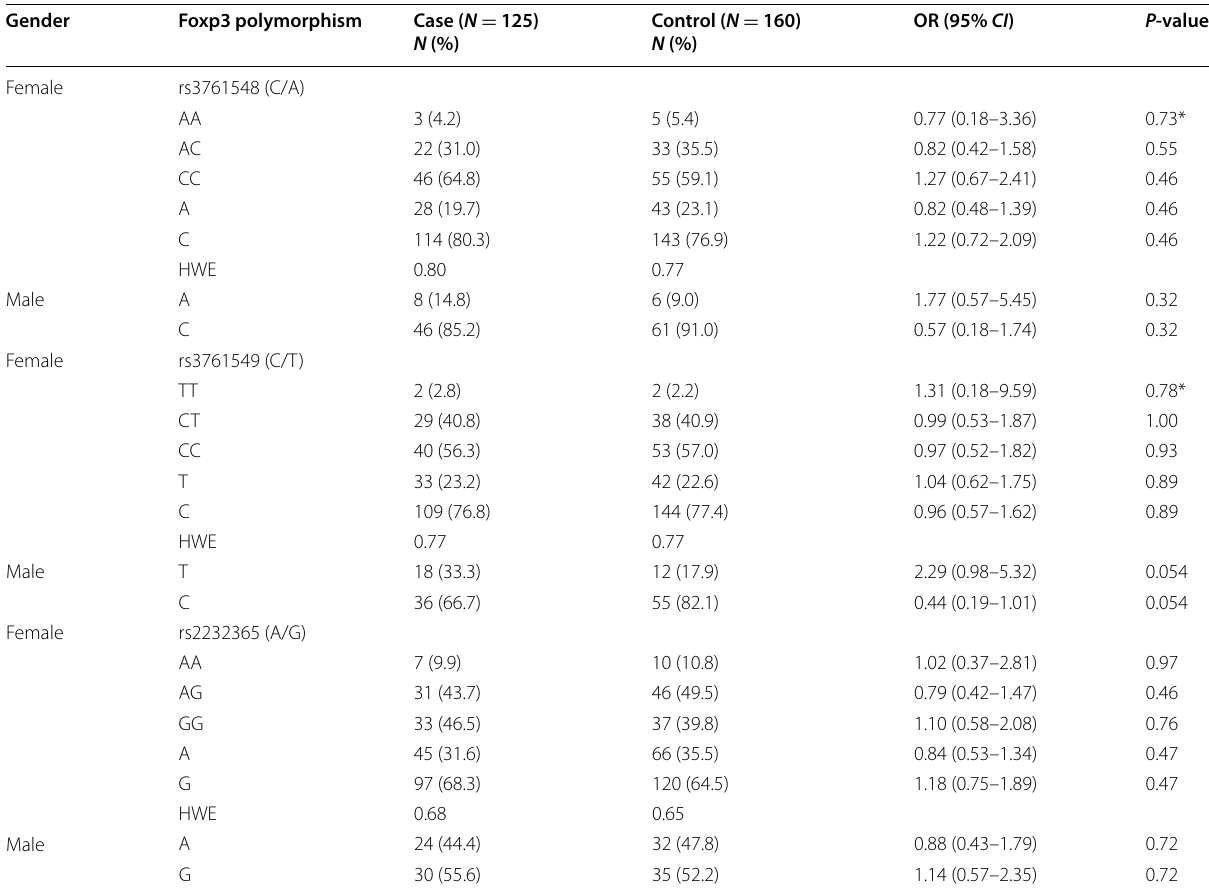
Table 3 Distribution of the FOXP3 alleles and genotypes in schizophrenia patients and healthy controls